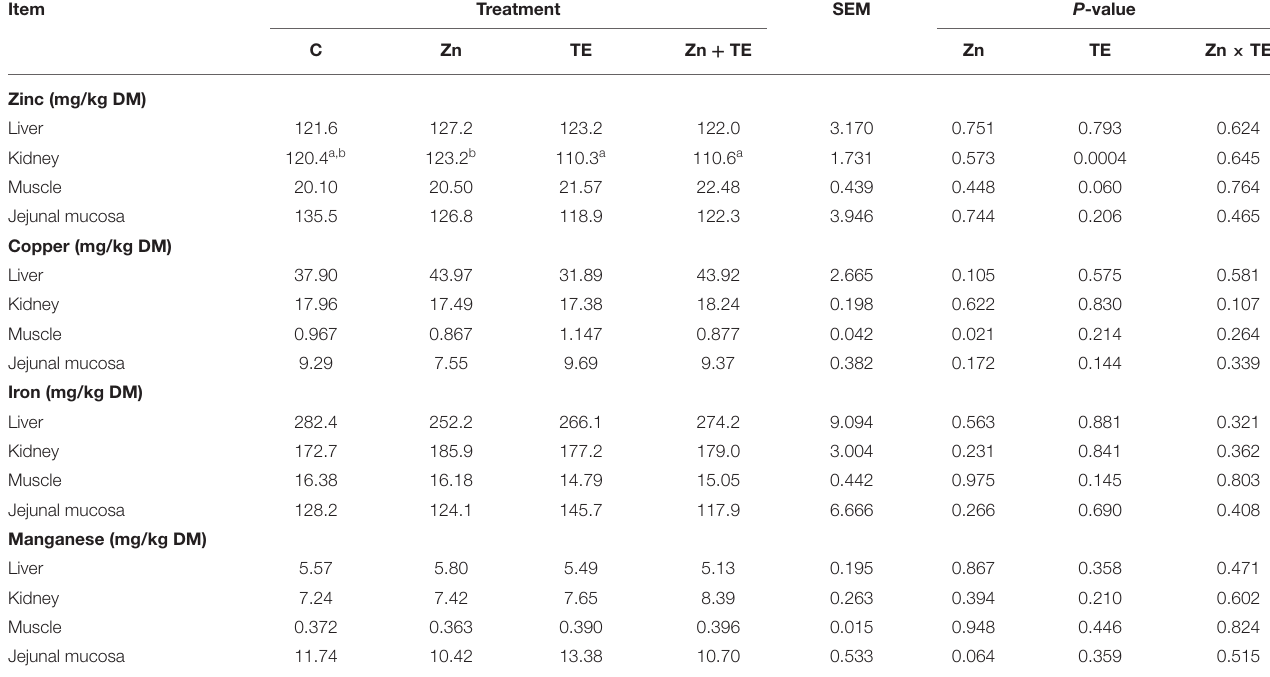
TABLE 5 | The effect of organic zinc and/or thyme extract administration on the concentration of microelements (Zn, Cu, Fe, and Mn) in the tissues of rabbits. Item Treatment SEM P